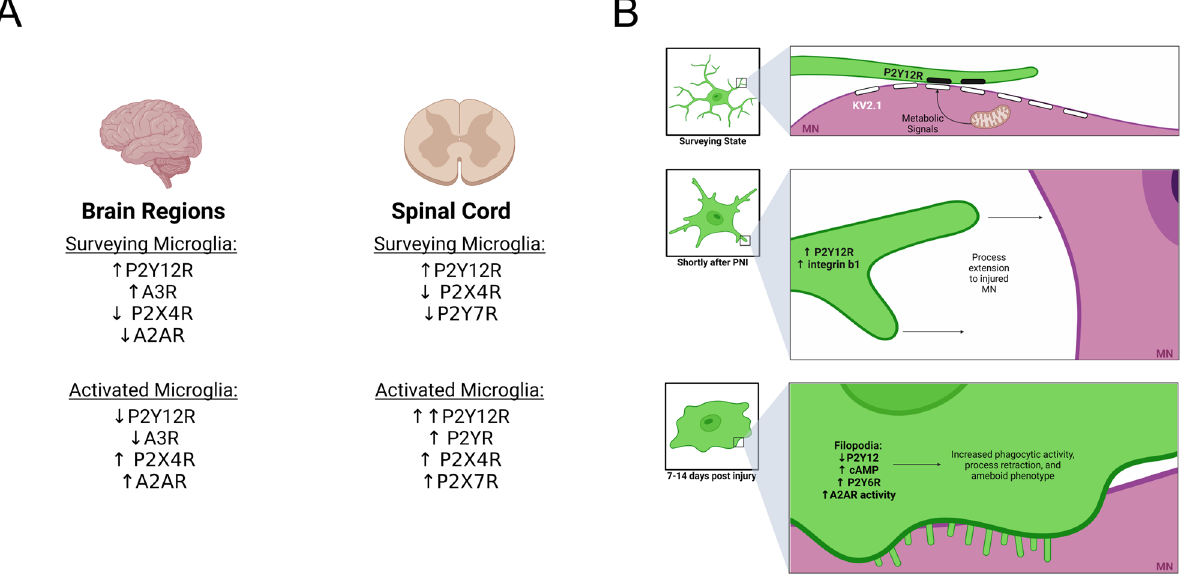
Figure 4. Purinergic signaling in spinal cord microglia following peripheral nerve injury. ( A ). Dif- ferences in purinergic receptor expression between microglia located in the brain versus spinal cord. ( B ). Possible purinergic signaling mechanisms between microglia (green) and motoneurons